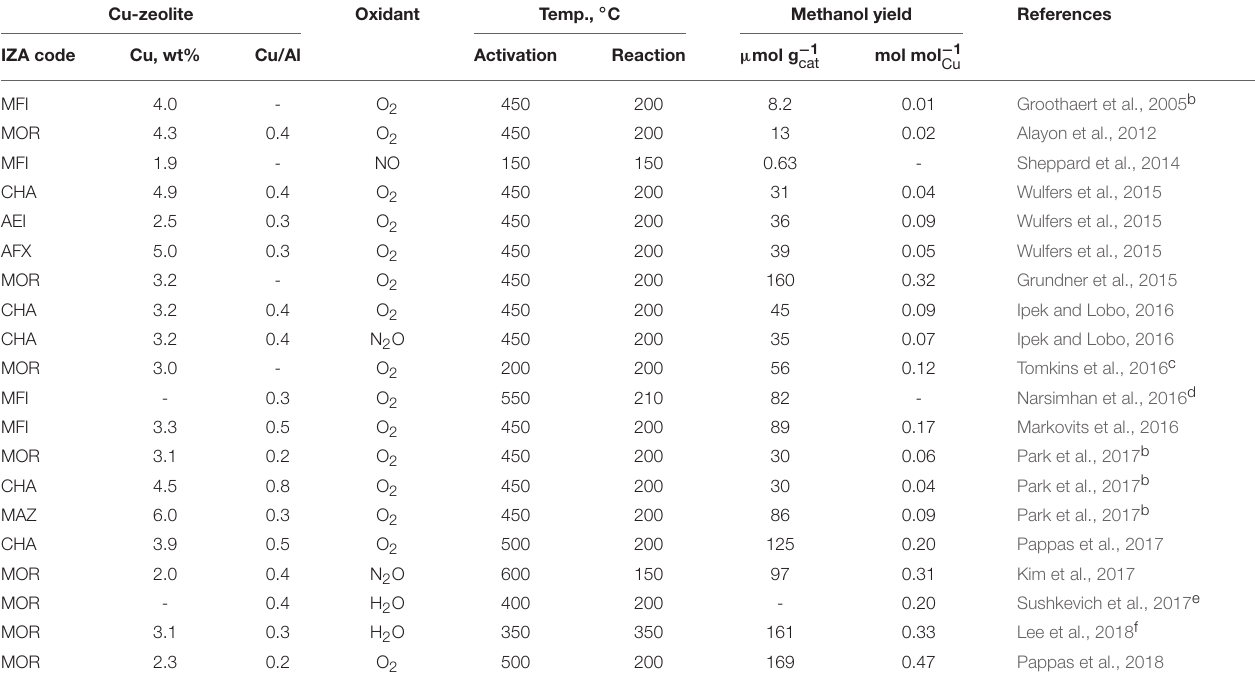
TABLE 1 | Representative Cu-zeolite performances reported for the gas-phase direct methane oxidation to methanol a . Cu-zeolite Oxidant Temp., ◦